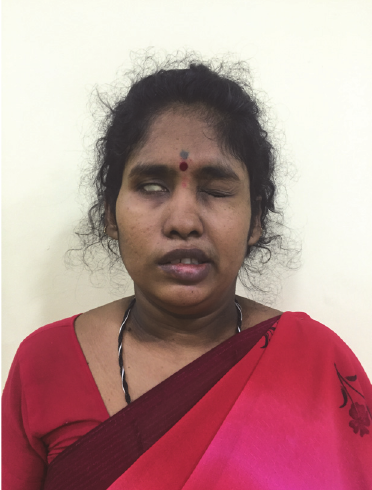
Figure 6: Postoperative image shows inability to close the right eyelid and upward rolling of right